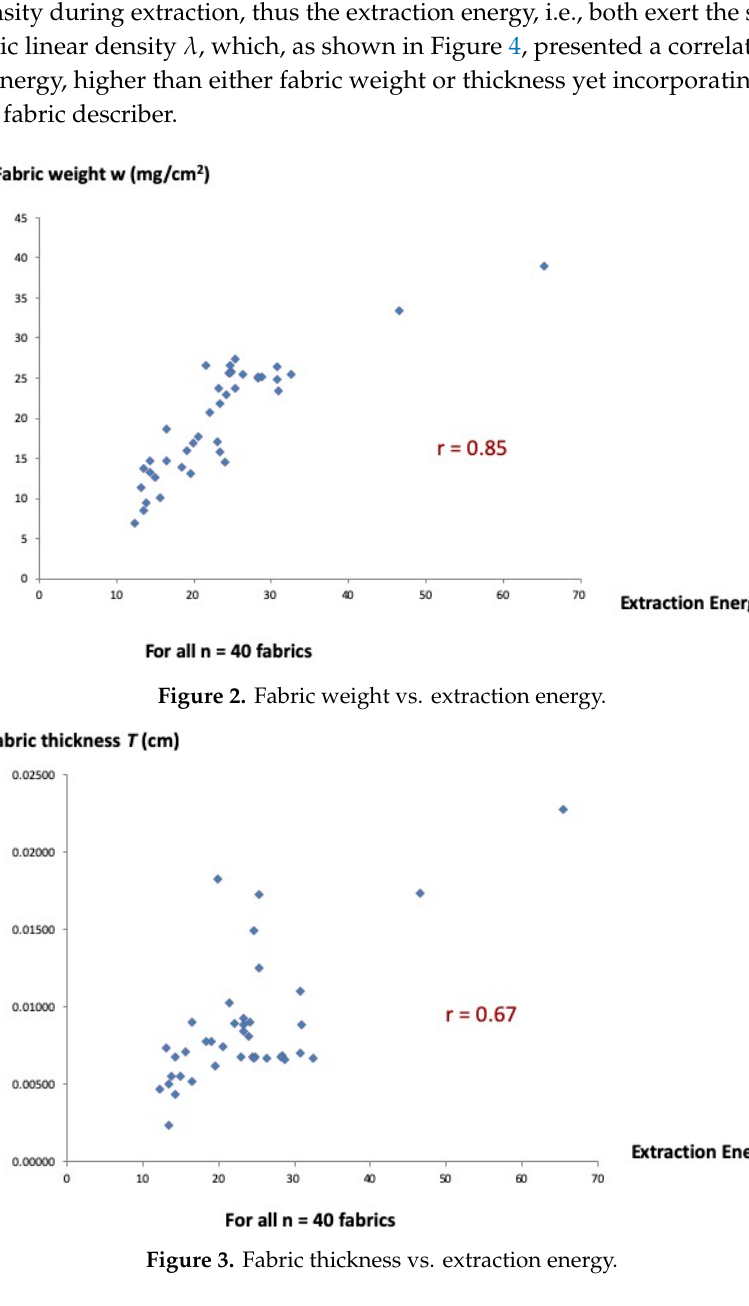
Figure 4. Linear density λ vs. extraction energy.